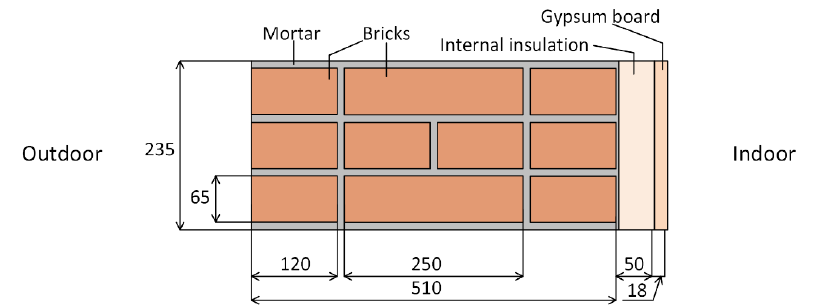
Fig. 1. 2-dimensional model of simulated masonry wall with internal insulation (all numbers are in